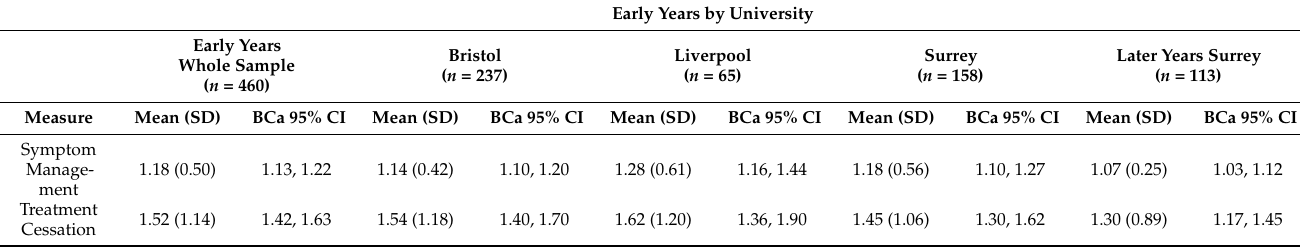
Table 3. Mean behavior